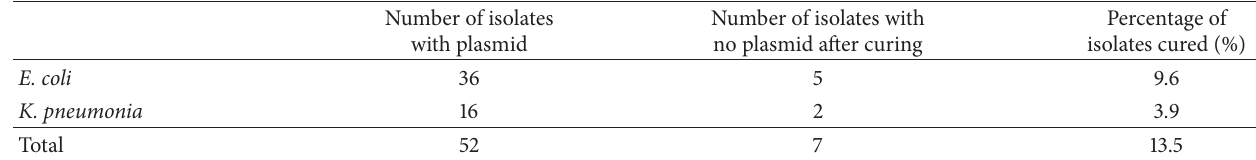
Table 5: Plasmid curing rate for the ESBL positive E. coli and K . pneumoniae